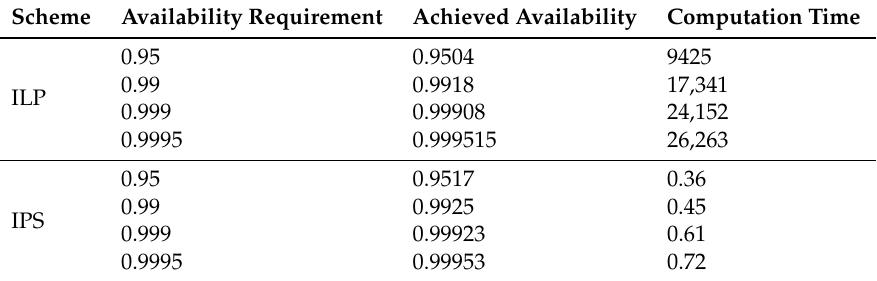
Table 2. A comparison of performance and the computation time overhead of ILP and